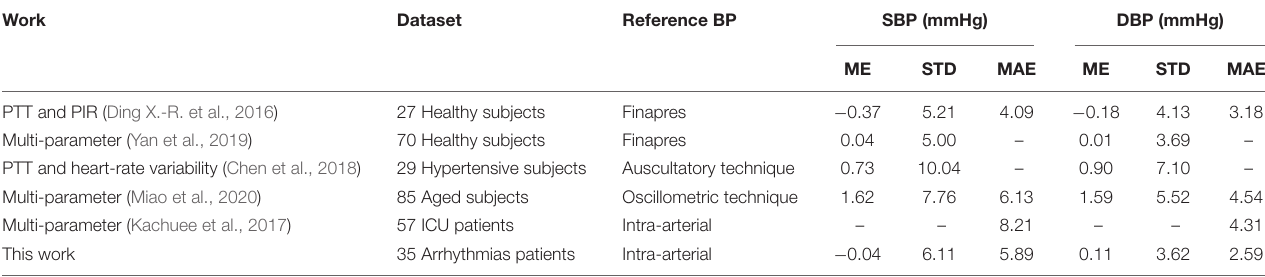
TABLE 5 | Comparison with other